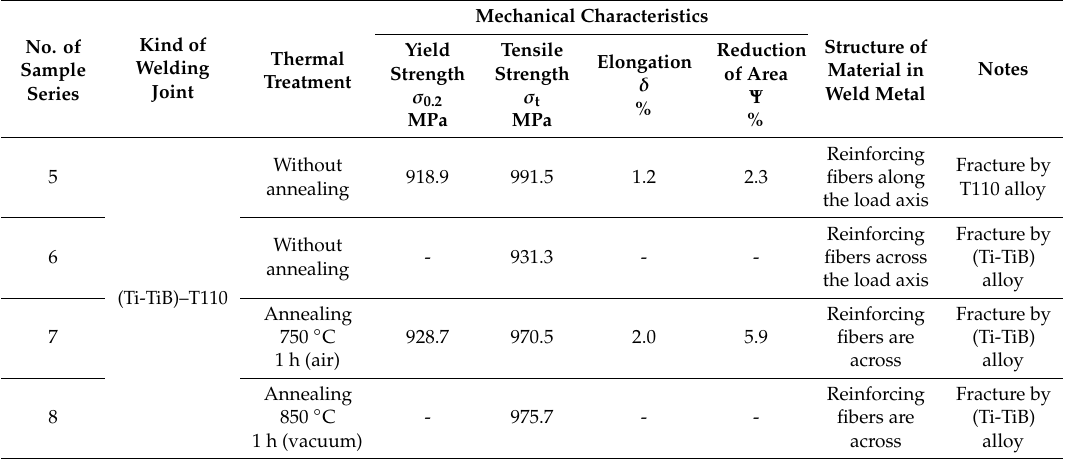
Table 4. Mechanical characteristics of welded joints of Ti-TiB alloy with T110 titanium alloy obtained by electron-beam